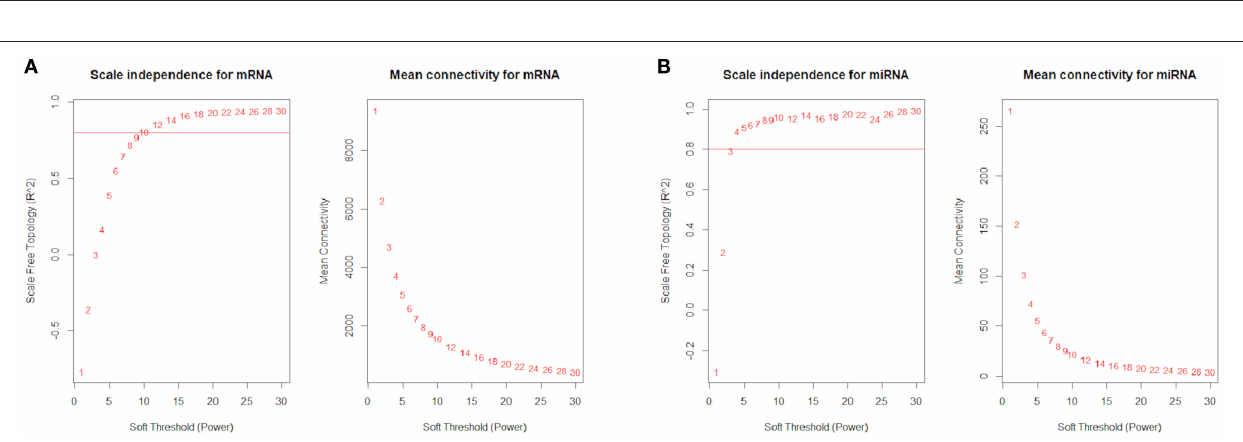
FIGURE 2 | R 2 of the free-scale topology and mean connectivity with soft threshold (power) for (A) mRNA data and (B) miRNA data.